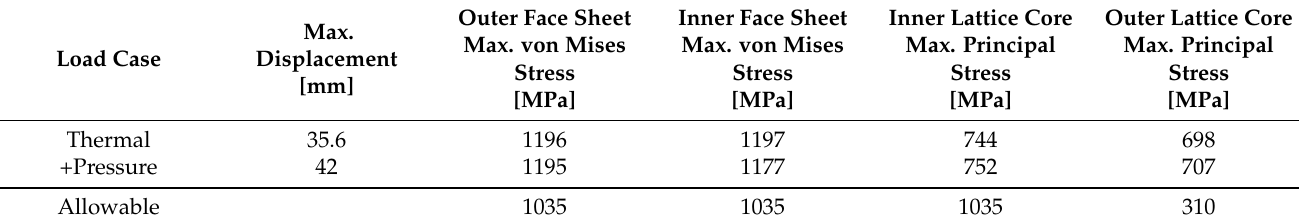
Figure 19. Deformation of the outer face sheet in millimetres on the lattice/PCM model for combined thermal and pressure loading. Cutouts represent the areas with local effects around the nodal constraints that were ignored in stress evaluations. Table 5. Results of the mechanical simulation for the lattice core/PCM solution (see evaluated area in Figure 19).